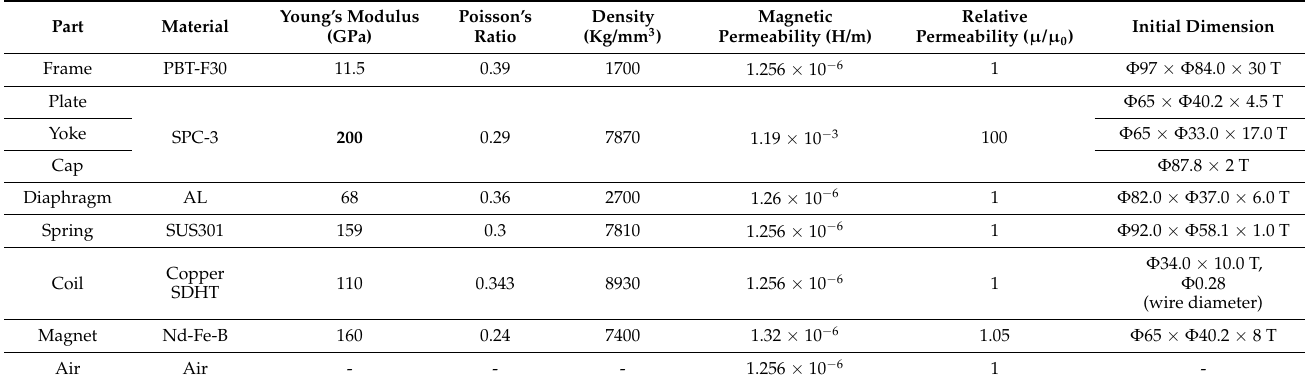
Table 1. Material property of virtual engine sound